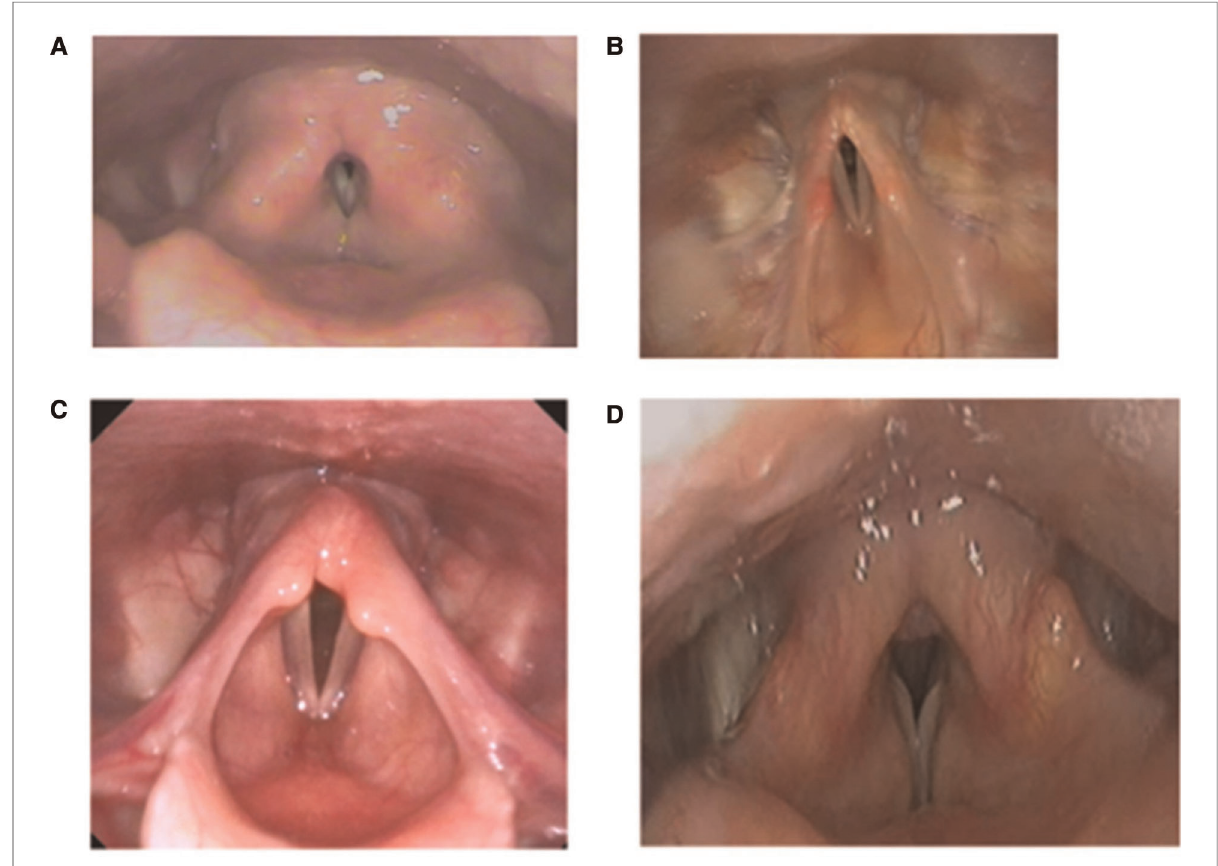
FIGURE 2 Laryngoscopy demonstrating ( A ) supraglottic constriction ( B ) aryepiglottic fold constriction, ( C ) shortened aryepiglottic folds and arytenoid prolapse at rest in an athlete with EILO, and ( D ) classic vocal cord dysfunction type